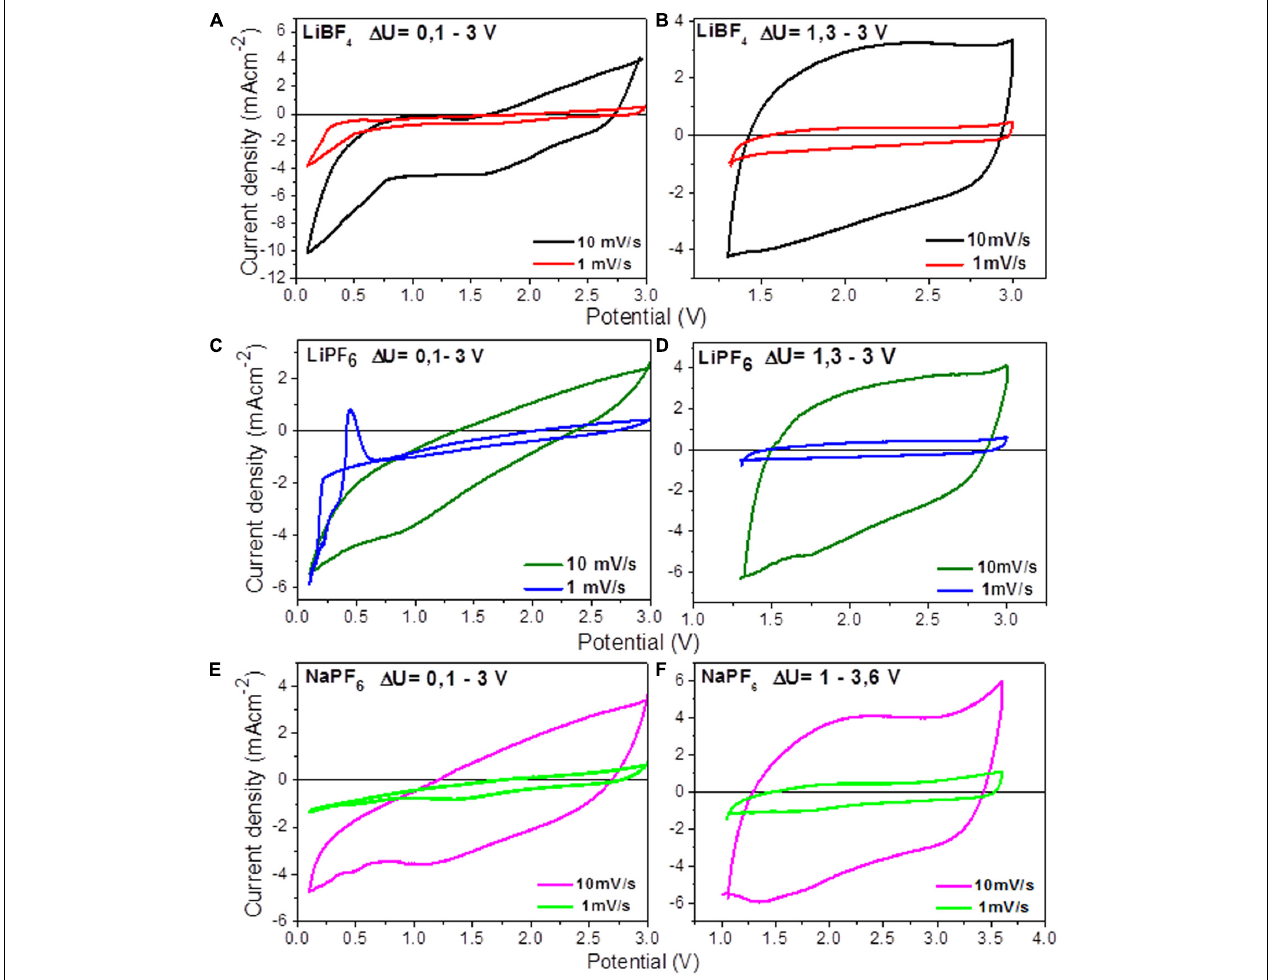
FIGURE 1 | Cyclic voltammetry curves of symmetric supercapacitor cells in organic electrolytes at different scan rates and voltage limits: (A) LiBF 4 (0.1–3.0 V), (B) LiBF 4 (1.3–3.0 V), (C) LiPF 6 (0.1–3.0 V), (D) LiPF 6 (1.3–3.0 V), (E) NaPF 6 (0.1–3.0 V), and (F) NaPF 6 (1.0–3.6